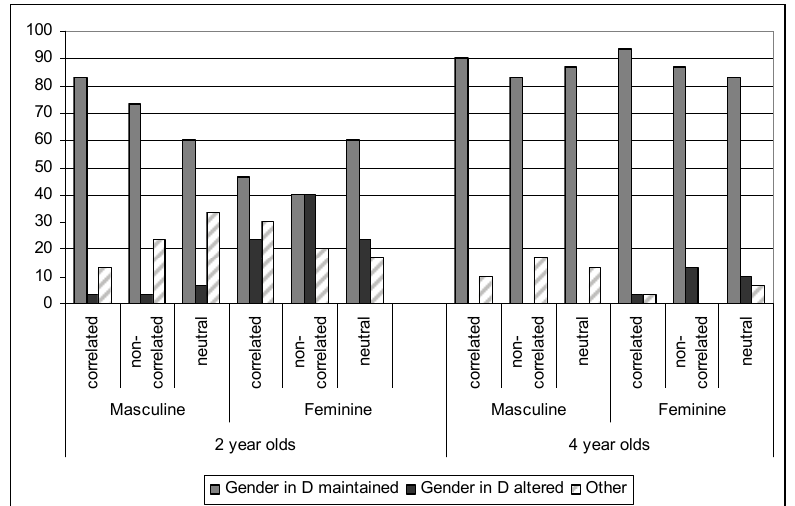
Figure 3: Distribution (%) of responses per condition in the BP group (n=30)